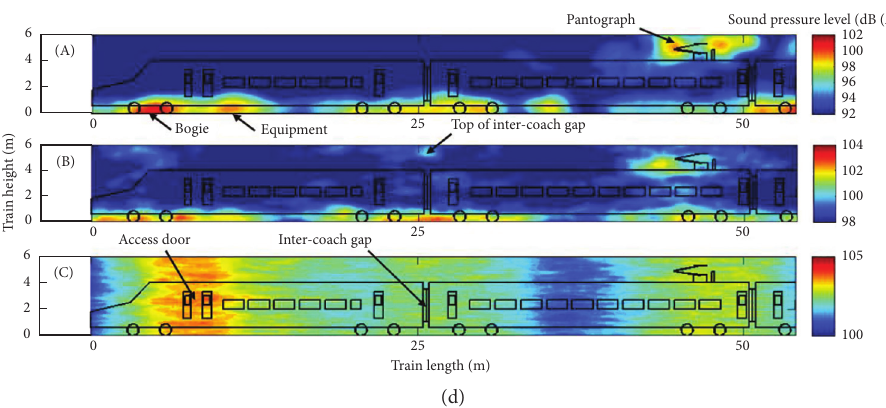
Figure 1: Classic noise source identification for different types of high-speed trains [17, 21, 22, 24]. (a) Noise source identification for TGV high-speed train (2006) [17]. (b) Noise source identification for Shinkansen high-speed train (2008) [21]. (c) Noise source identification for KTX high-speed train (2013) [22]. (d) Noise source identification for CRH high-speed train (2014) [24].